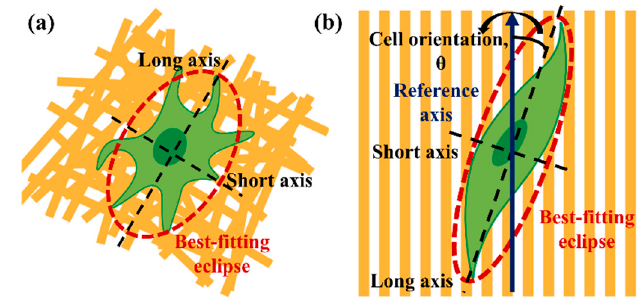
Figure 2. The evaluation of cell elongation and orientation. Illustration of ( a ) cell on the tissue culture plate or flat random scaffold and ( b ) cell on the structural scaffold. Cell elongation in terms of aspect ratio was measured by dividing the length of the long axis by the short axis. The cell orientation was determined by the angle between the long axis of the ellipse and the pattern direction.